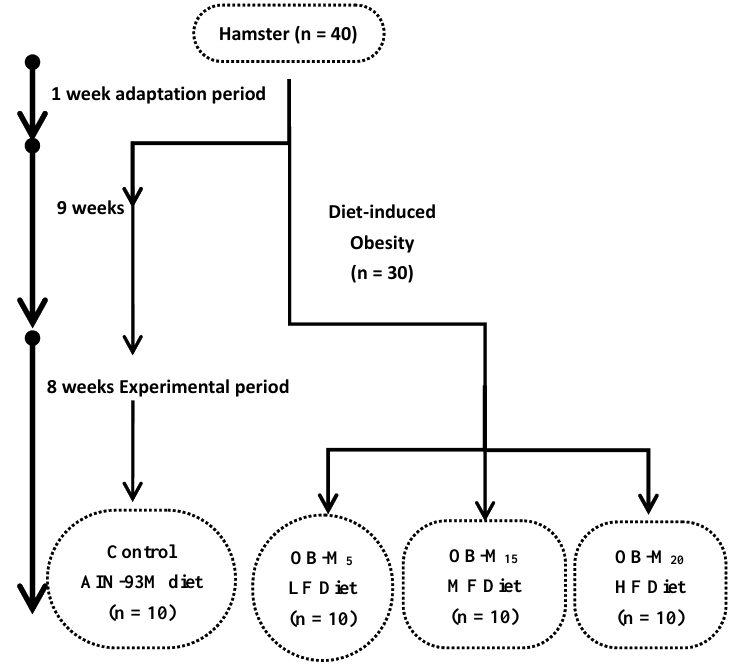
Figure 1. The schema of the experimental protocol. Table 1. Composition of the experimental diets.